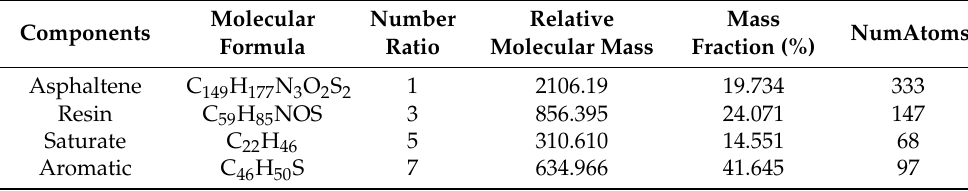
Table 1. Specific information about the asphalt